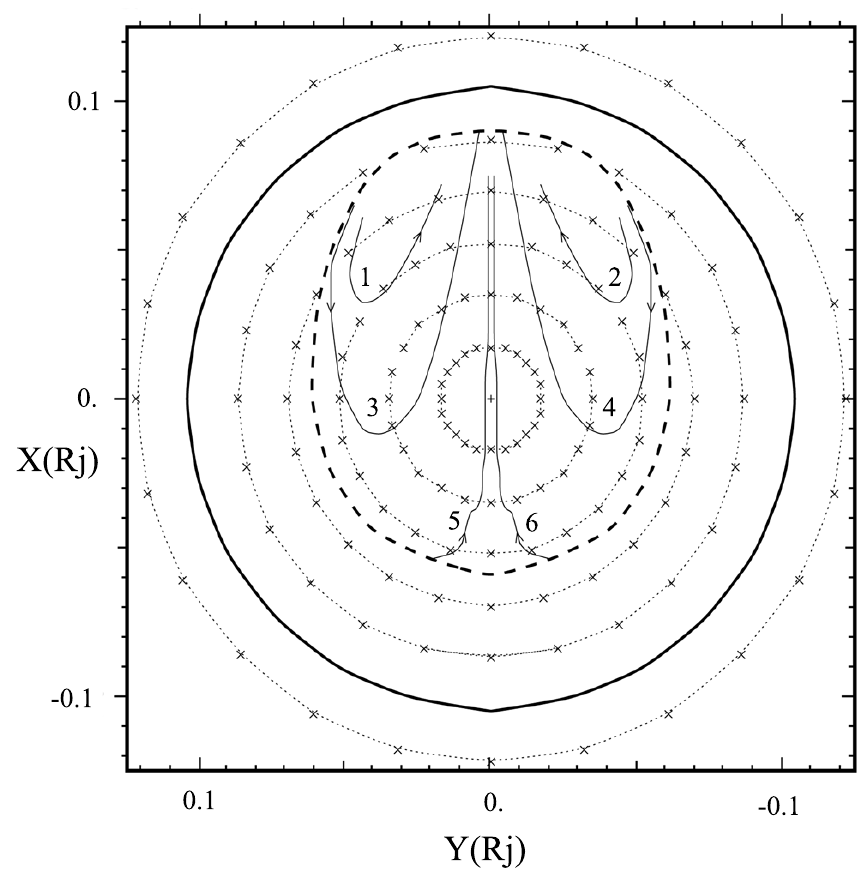
Fig. 4. The northern Jovian polar cap for southward IMF ( B IMFx =− 0 . 26nT; B IMFy = 0nT; B IMFz =− 0 . 5nT) with κ J = 0 . 8. The model parameters are: ψ = 0; R ss = 100 R J ; R 2 = 65 R J ; B t =− 2 . 5nT; R D 1 = 92 R J ; R D 2 = 18 . 4 R J ; B DC = 2 . 5nT. The Sun is on the top; positive Y corresponds to the dusk side. Dotted lines with crosses mark lines of constant latitudes (from ∼± 83 ◦ to ∼± 90 ◦ ). The dashed curve marks the open field line boundary. The bold solid circle is the corotation boundary. The solid curves are equipotentials of the solar wind electric field: “1” corresponds to the potential 0 . 6MV; “2” corresponds to − 0 . 6MV; “3” corresponds to 0 . 3MV; “4” corresponds to − 0 . 3MV; “5” corresponds to 0 . 03MV; and “6” corresponds to − 0 .